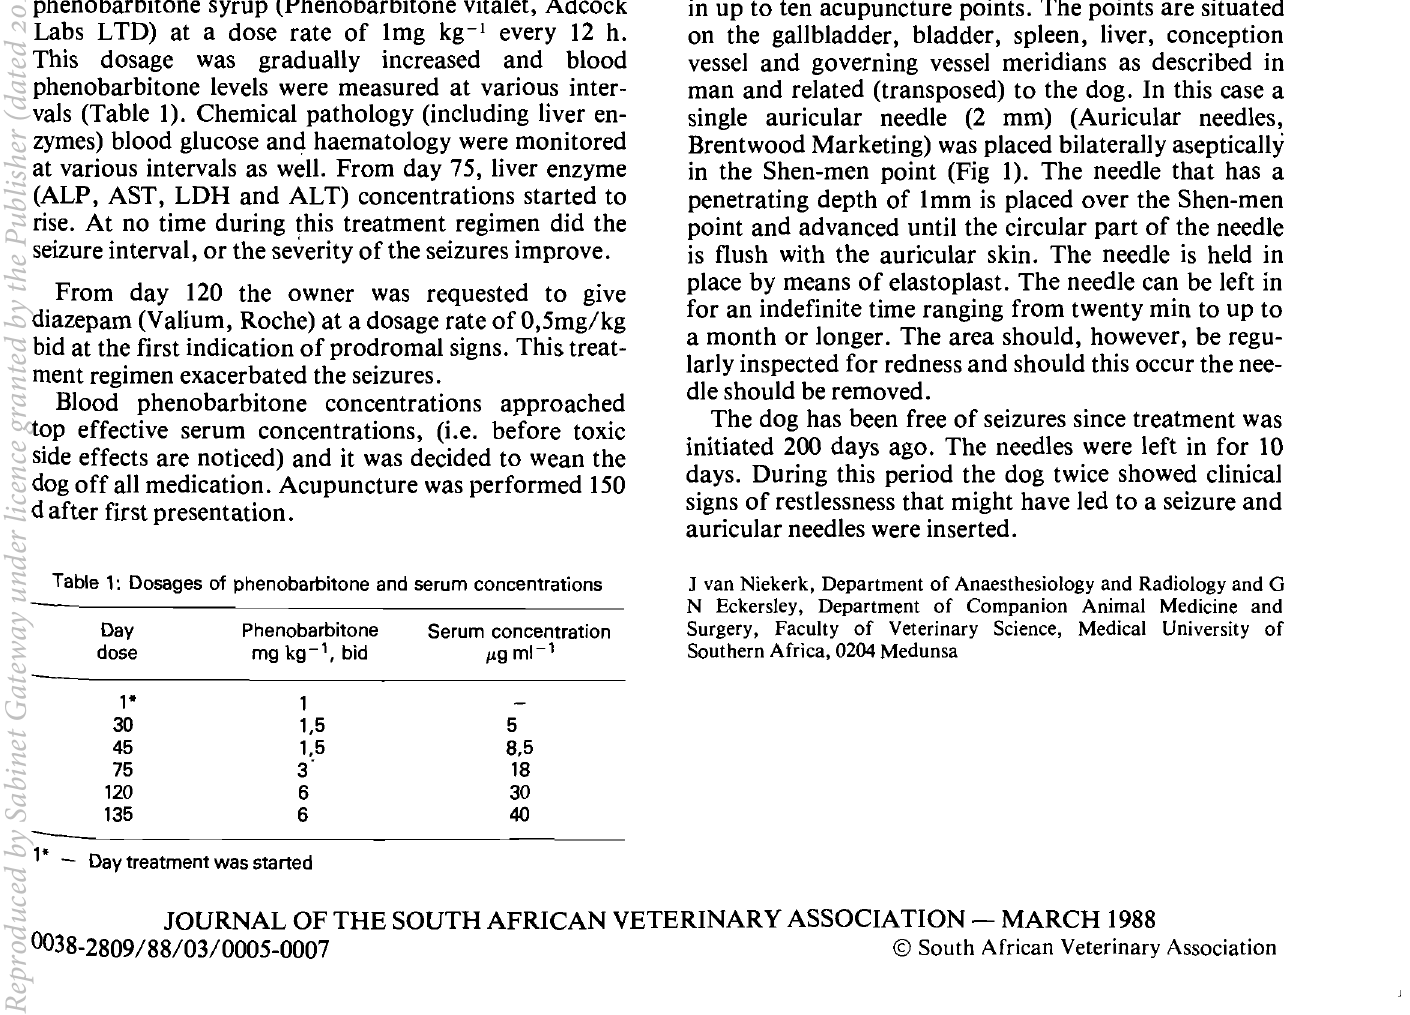
Table 1: Dosages of phenobarbitone and serum